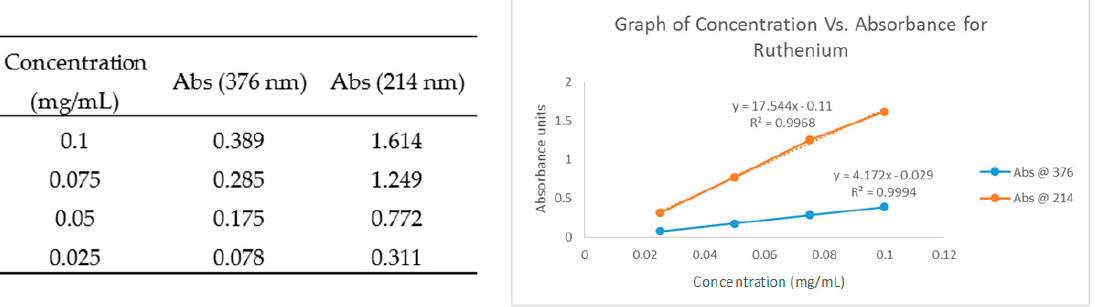
Figure 3. Hoveyda–Grubbs Second-Generation Calibration